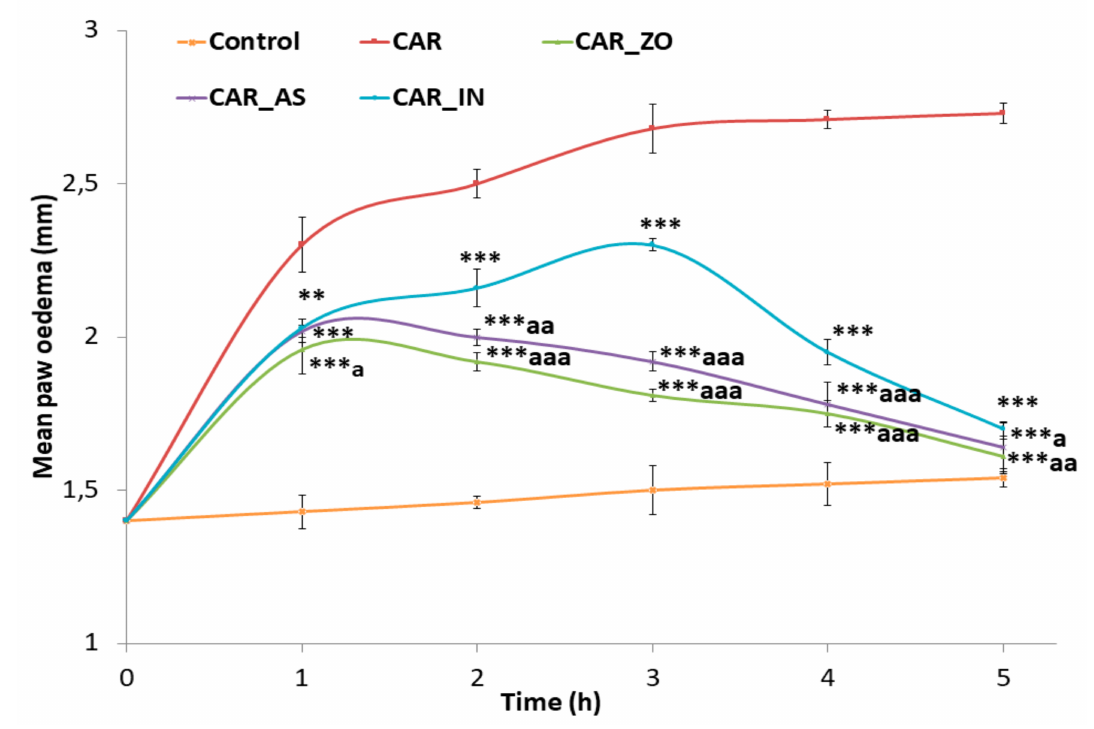
Figure 1. Changes in edema size after CAR injection in experimental animals: Control: non-treated rats, received injection with isotonic saline solution (NaCl, 0.9%); CAR: inflamed rats by Carrageenan (1%); CAR_ZO, CAR_AS and CAR_IN: rats inflamed by CAR and treated with ZO, AS or indomethacin respectively. *, **, *** for p < 0.5, 0.01 and 0.001 vs. CAR and a , aa , aaa for p < 0.5, 0.01 and 0.001 vs. CAR_IN.